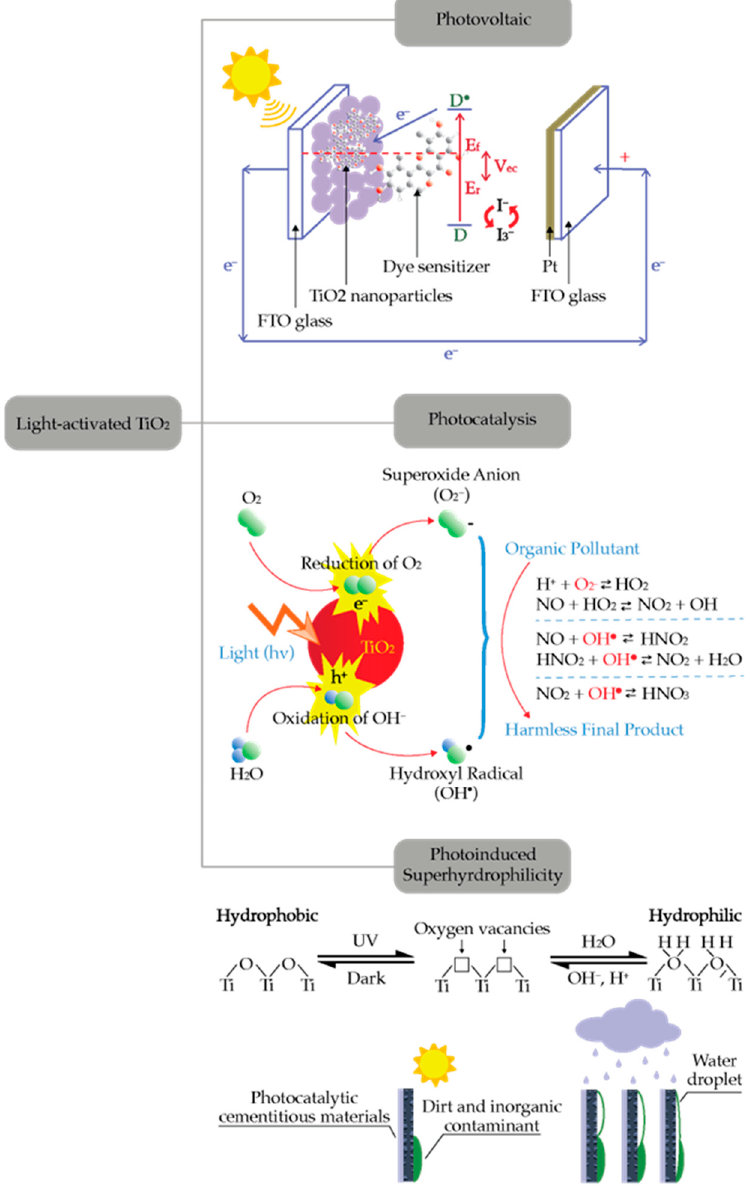
Figure 3. Applications of light-activated TiO 2 .